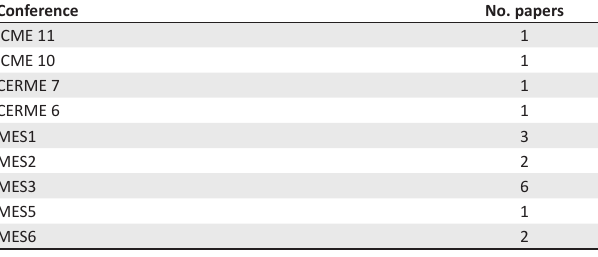
TABLE 2: Overview of the references consulted for the development of the literature review: Layer 2 − Conference proceedings.